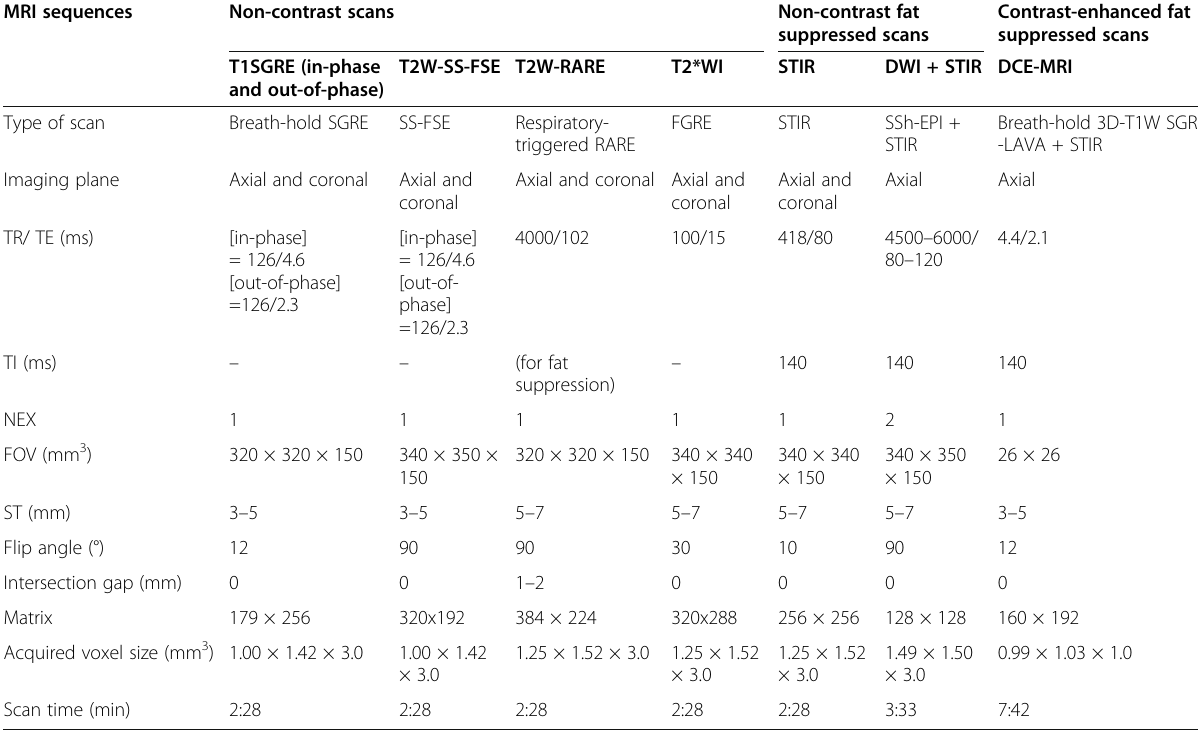
Table 1 Parameters of the standard MR imaging sequences of liver used in the study MRI